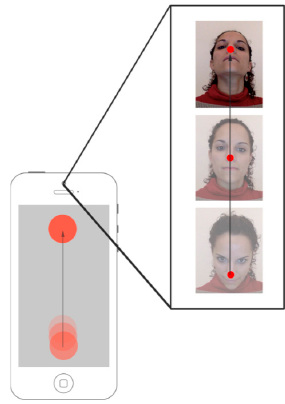
Figure 6. The camera-based interface processes the user’s head motion to translate it to a position in the mobile’s screen.